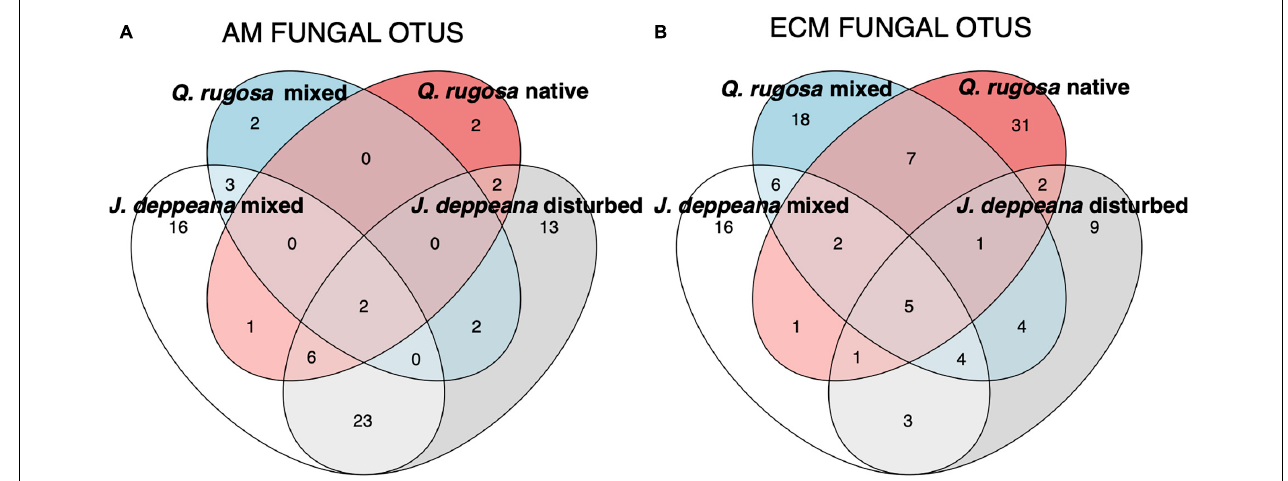
FIGURE 3 | Venn diagram showing mycorrhizal fungal OTUs detected in the roots of each plant host and site. (A) Arbuscular mycorrhizal (AM) fungal OTUs, (B) Ectomycorrhizal (ECM) fungal